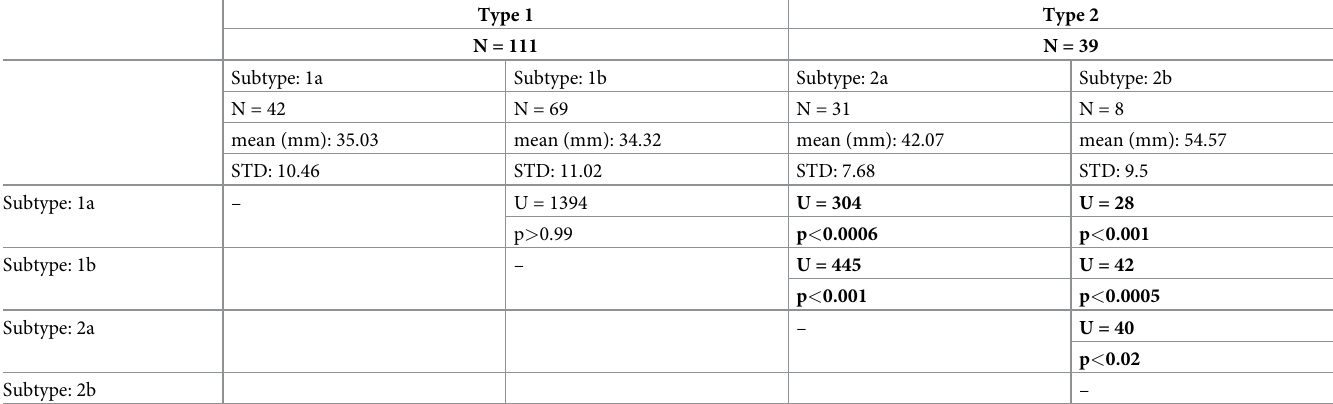
Table 3. Significance test results for the neck’s curve among the